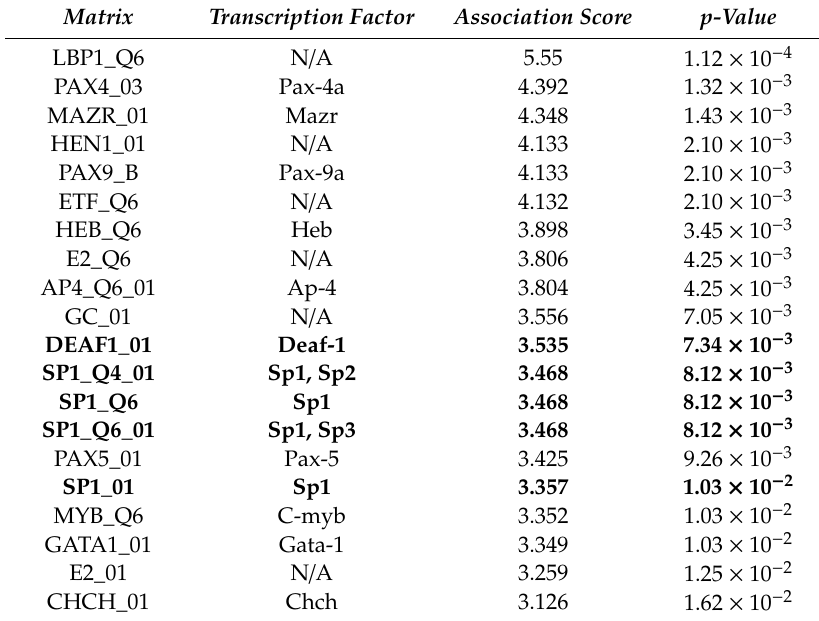
Table 3. Proximal analysis ( ± 400 bp) of genes commonly a ff ected by siRNA SH inhibition and ML114 treatment.